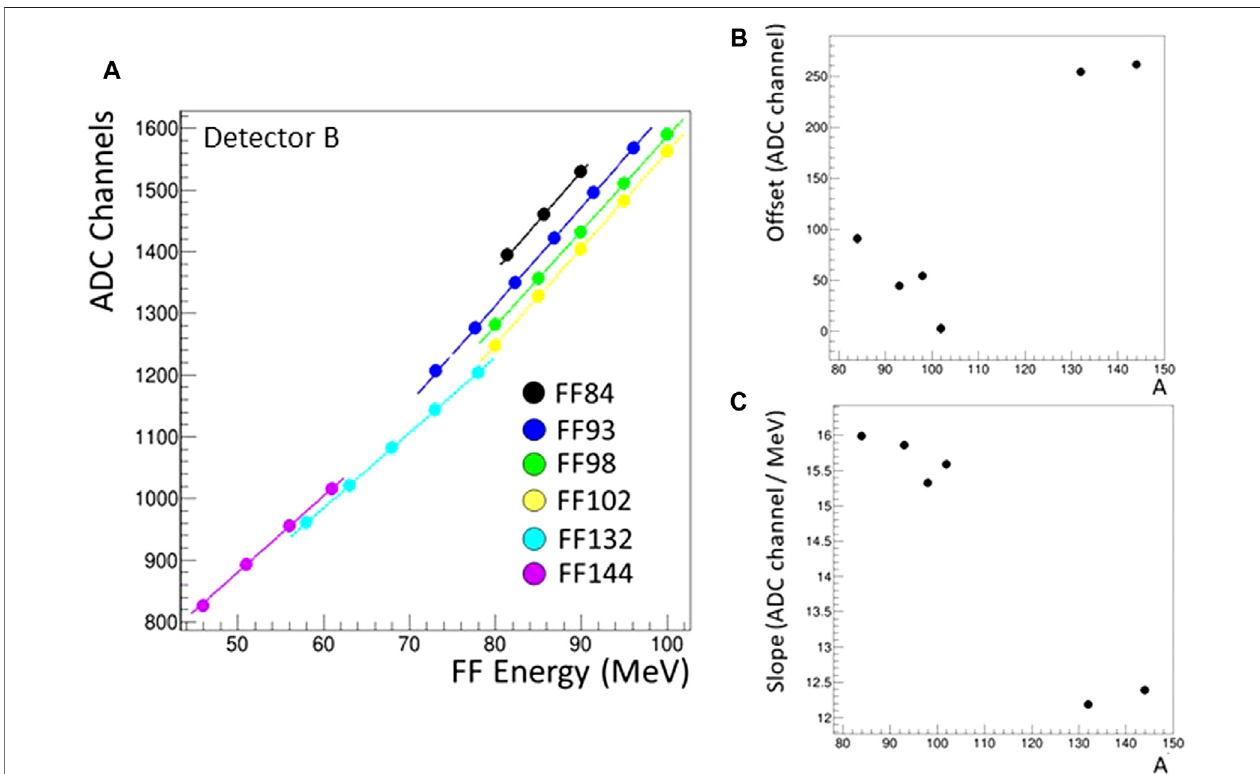
FIGURE 11 | (A) ADC channels versus incoming fragment kinetic energy for a set of FF selected with LOHENGRIN (diamond detector B). The offset (B) and slope (C) parameters as a function of the ionic mass A of incoming FF on diamond detector B surface 0 ° . The bias voltage is -200 V. Error bars are within the point size. The observeddependency in (B) and (C) forlightFFseems tobecomplexsincethecorrespondingpointforFF98 stands outinthetwodistributionsand seems toexcludea purely linear dependency as reported in [5] for silicon detector operated at LOHENGIN in very similar experimental